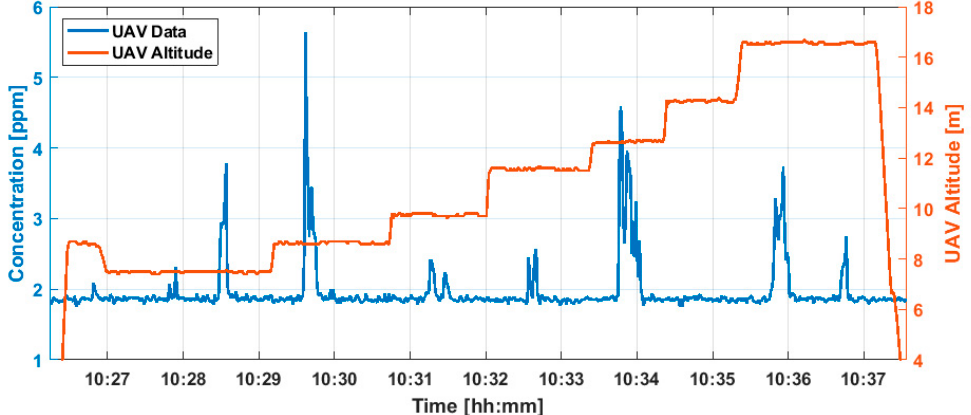
Figure 6. Plume detection by sUAS sensor due to controlled release of mass flow 0.5 g/s.